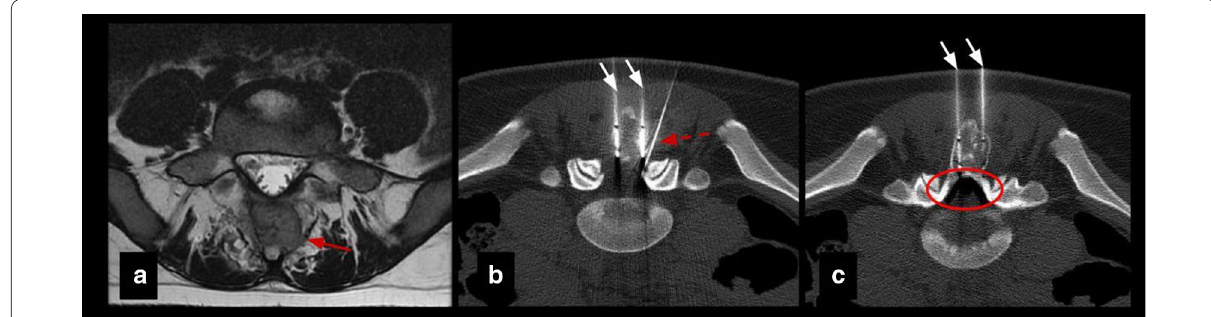
Fig. 2 Insulation technique: epidural pneumo‑dissection. Osteoblastoma in a 17‑y.o patient. a Axial T2 MR image shows an expansile lesion in the posterior elements of L5 (red arrow). b , c Axial CT images show cryoprobes (white arrows) and epidural needle (dashed arrow) for pneumo‑dissection system (circle) used to protect L4 and L5 nerve